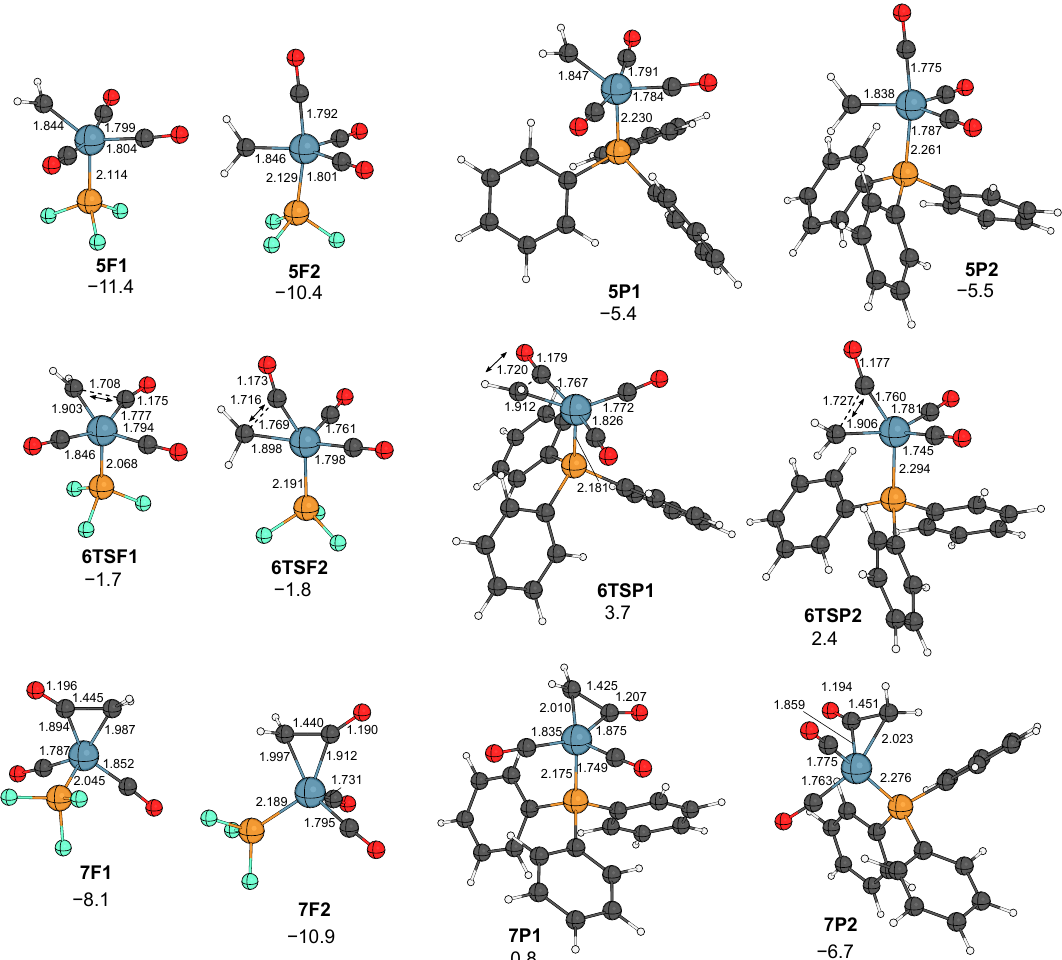
Figure 5. Computed minimum structures and the transition states describing the carbene–carbonyl coupling for the PF 3 and PPh 3 pathways for the CO uptake step leading to coordinatively saturated ketene complexes. Bond distances are in Å, Gibbs free energy values are given in kcal/mol, and they are relative to 1F and 1P